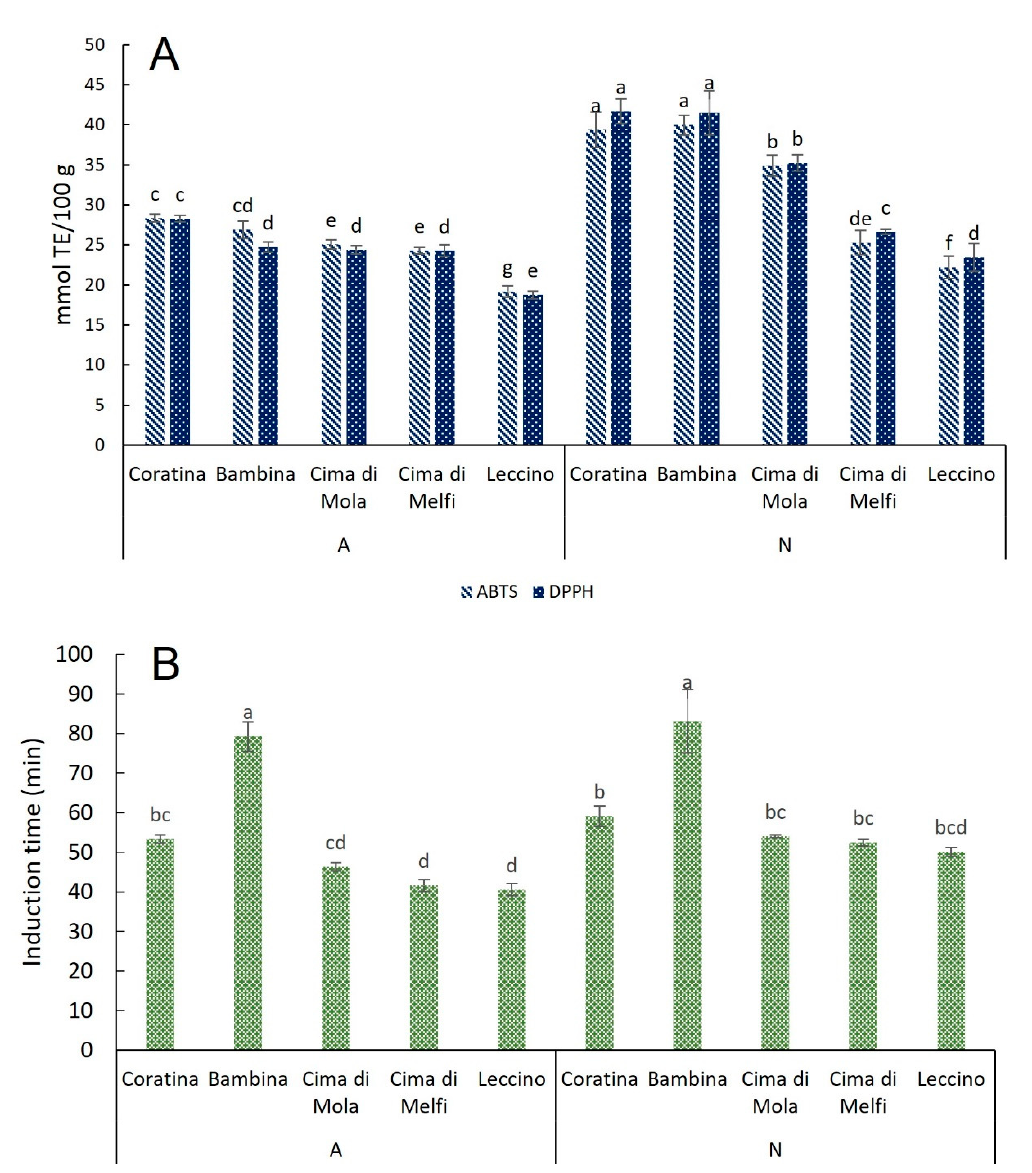
Figure 4. Mean values, standard deviations, and results of statistical analysis (two-way ANOVA) of the antioxidant activity evaluation on olive leaf extracts ( A ) and RapidOxy evaluation ( B ). Different letters indicate significant differences at p < 0.05.